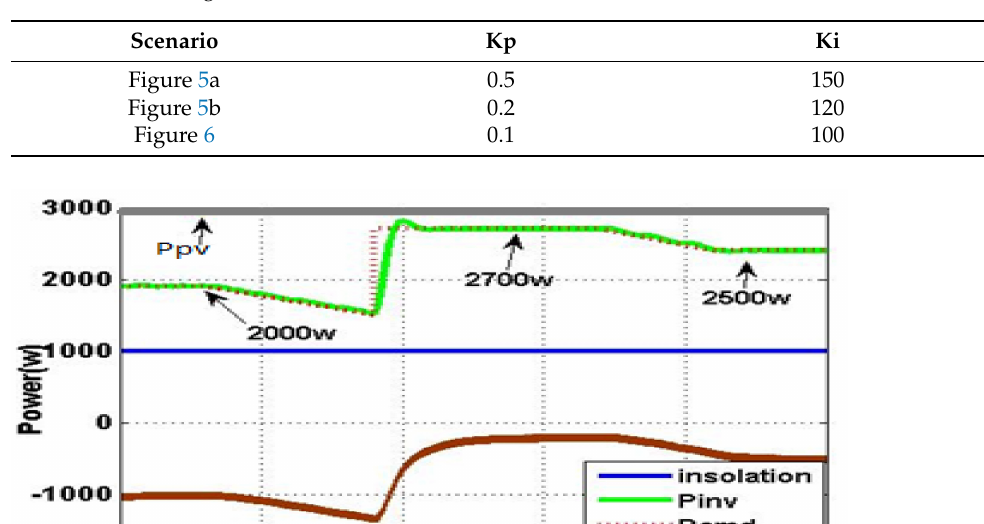
Table 2. Gain tuning for PI controller.